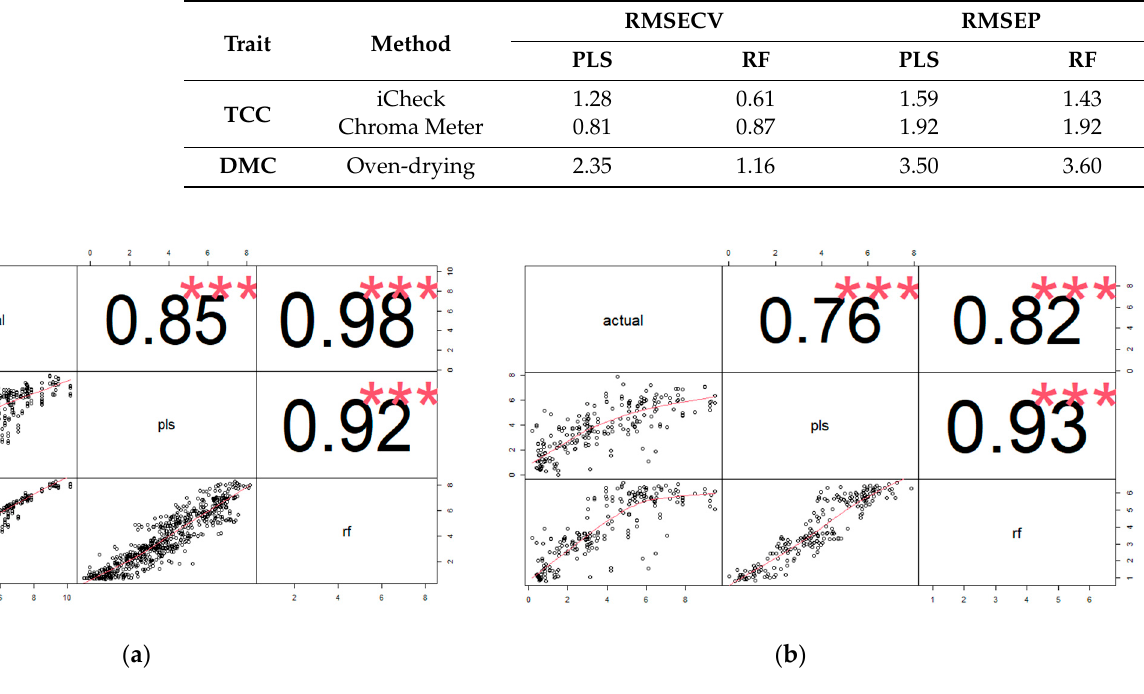
( b ) Figure 5. Correlation between actual and predicted DMC values using PLS and RF calibration models in the training ( a ) and validation sets ( b ). 4. Discussion This study is important in sustaining the ongoing effort in TCC improvement, especially in low-resource breeding programs and off-site breeding stations. While the generation of the adequate calibration set from African germplasm that has trait values derived from a standard reference method such as HPLC might not be visible in the near future, the use of long-existing references from proxy alternatives for the calibration of the newly adopted near-infrared spectrometers will benefit the ongoing effort in TCC evaluation and genetic improvement. This study helps in developing strategies for the efficient phenotyping transition to NIRS technology, particularly the adoption of the portable NIRS. The early sampling approach needed for adequate sample homogeneity